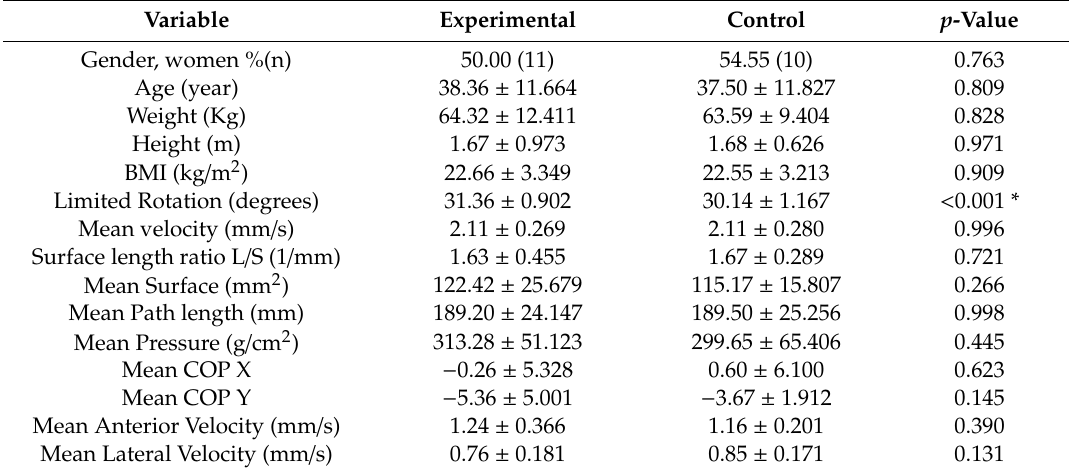
Table 1. Descriptive baseline data of the experimental and control group. Means ± standard deviation are shown for continuous variables, and % (n) is shown for categorical